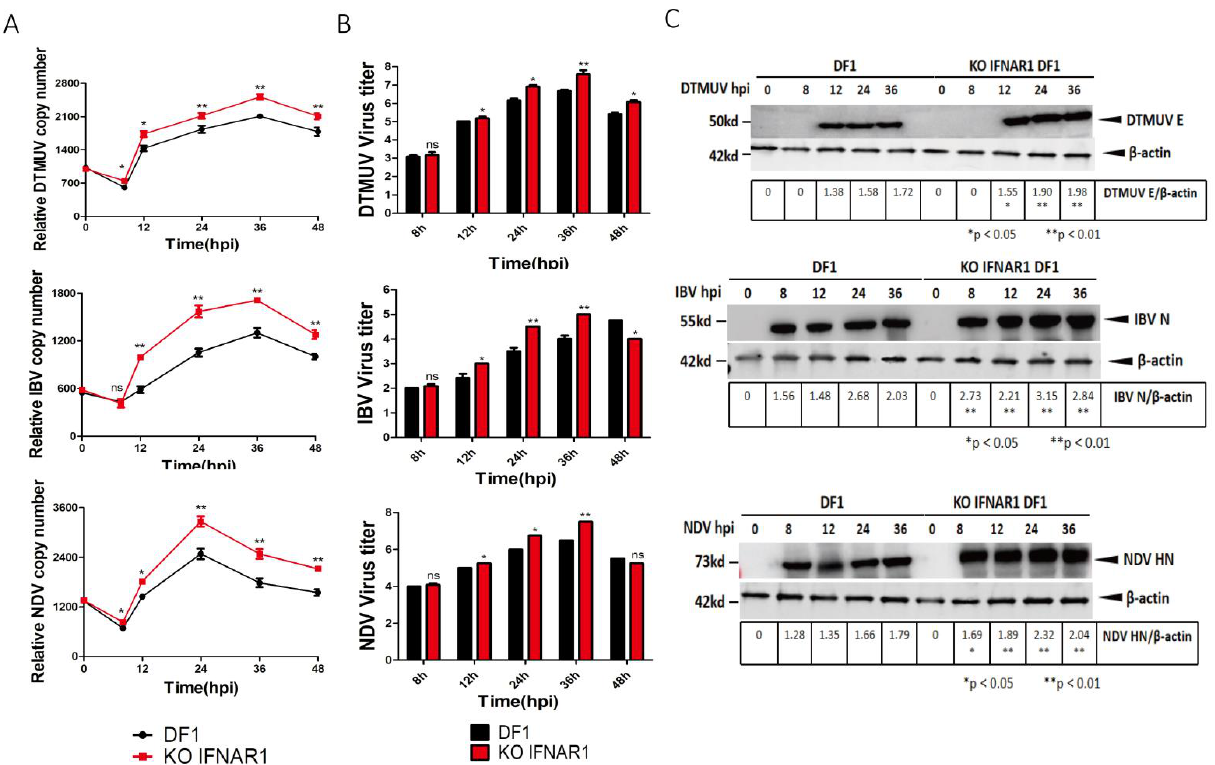
Figure 3. Knockout of KO-IFNAR1 promotes the replication of DTMUV, IBV and NDV. ( A ) Wild type (DF-1) and IFNAR1-knockout (KO-IFNAR1) cells were infected with DTMUV, IBV and NDV at an MOI ⁓ 1, and harvested at 0, 8, 12, 24, 36 and 48 hpi, respectively. Genomic RNA levels of DTMUV, IBV and NDV were determined by RT-qPCR and presented. * p < 0.05; ** p < 0.01; ns, non- significant. ( B ) Viral titers were determined by TCID50(Log10TCID50/0.1mL) from the extracellular fluids of DF-1 and KO-IFNAR1 cells harvested as in ( A ). Error bar represents the standard error of three replicate experiments. T tests were conducted between DF-1 (black) and KO-IFNAR1 (red) cells. * p < 0.05; ** p < 0.01; ns, non-significant. ( C ) Total cell lysates were prepared in parallel. The replication of DTMUV, IBV and NDV were assessed by Western blot with anti-DTMUV-E, anti-IBV-N and anti-NDV-HN antibodies. β -actin was detected as a loading control. * p < 0.05; ** p < 0.01; ns, non-significant.